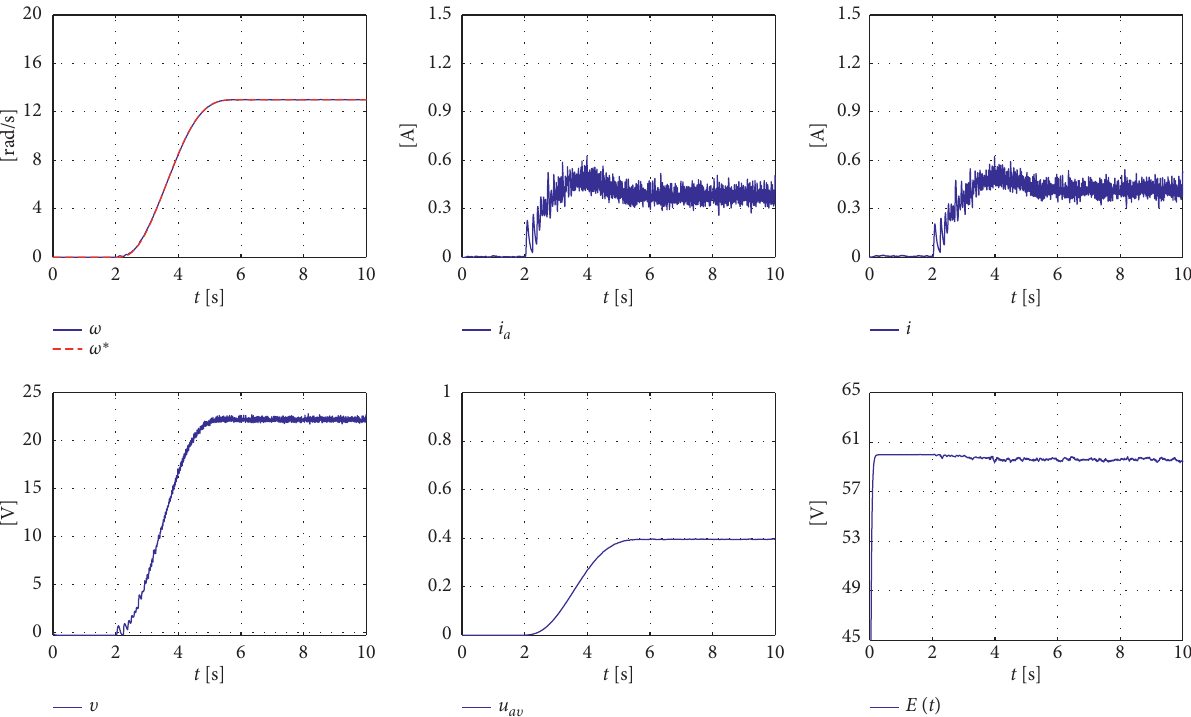
Figure 15: Experimental results of the DC/DC Buck converter-DC motor system in closed loop when E ( t ) (equation (25)) is generated through the TDK-Lambda G100-17 programmable power supply, via the solar panel TS-S425, and the perturbations (equation (28)) are imposed in C .